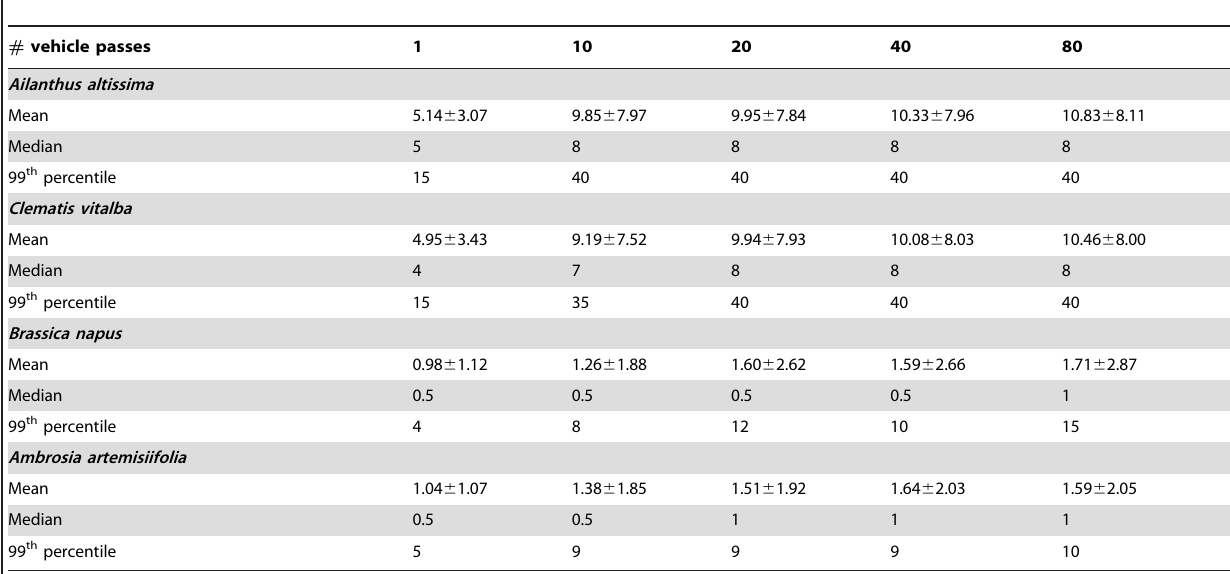
Table 2. Dispersal distances for the study species after different numbers of vehicle